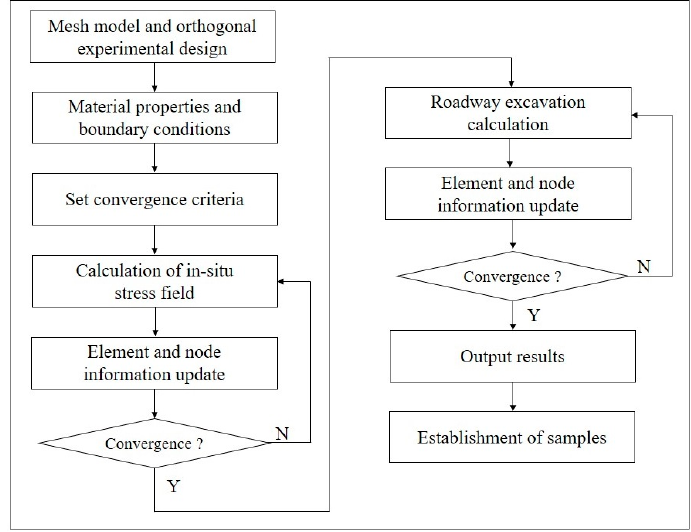
Figure 3. Flow chart of numerical analysis and sample establishment.